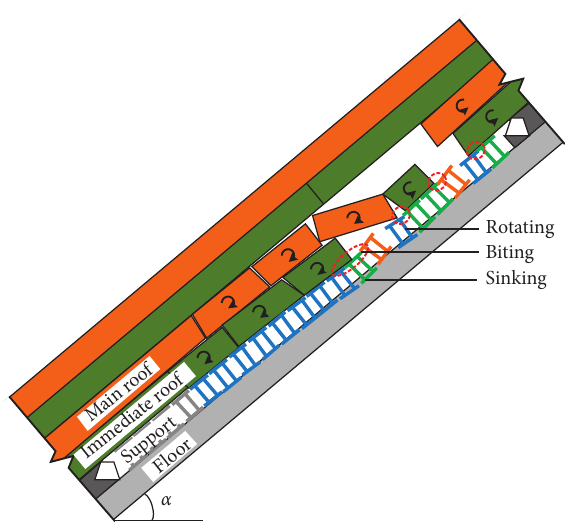
Figure 8: Interaction relationship of “support-surrounding rock” system along the inclined direction.